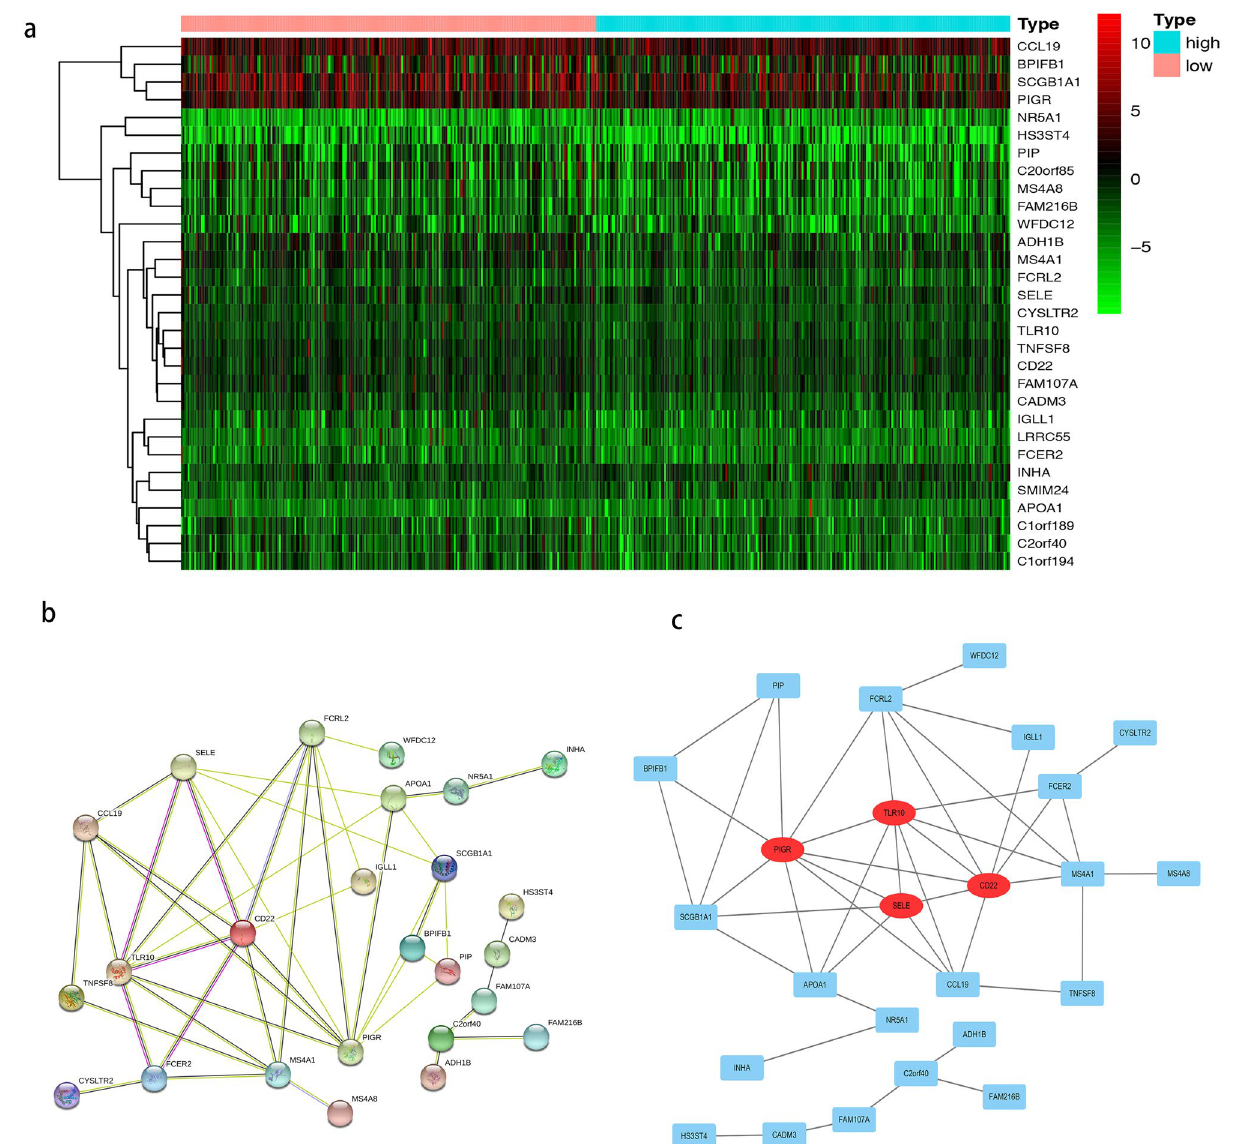
Figure 1. Identification of DEGs in LUSC between tumor and normal tissues. ( a ) The heatmap of DEGs between the high ‐ TMB and low ‐ TMB groups in LUSC by analysis of the TCGA datasets. Each column represents a sample, and each row represents one of DEGs. The levels of DEGs are shown in different colors, which transition from green to red with increasing proportions. The lines before the heat map indicated the dendrogram of DEGs cluster analysis. ( b ) The protein–protein interaction network (PPI) analysis was constructed by all the 30 DEGs using STRING database. ( c ) Four hub genes (PIGR, TLR10, SELE and CD22) in the PPI were screened by Cytoscape based on their connectivity degree. Red circles indicated four hub